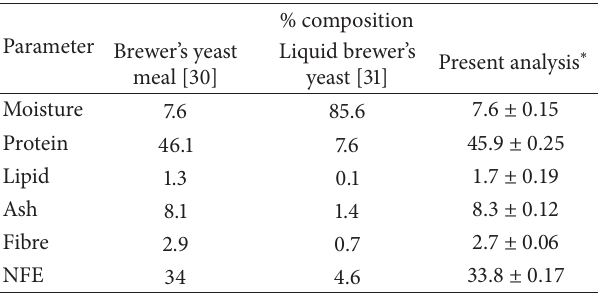
Table 1: The proximate composition of brewer’s yeast slurry (Sac- charomyces cerevisiae)